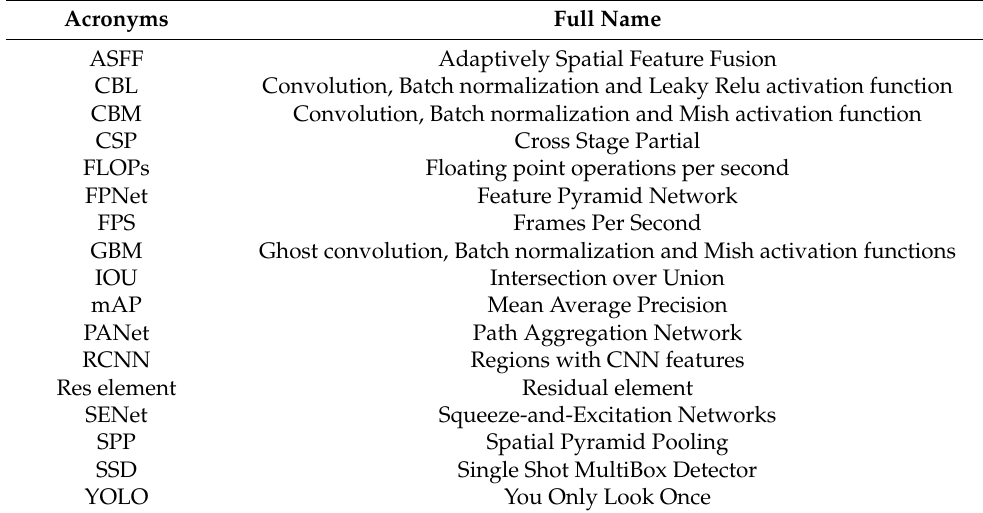
Table 1. The acronyms and full